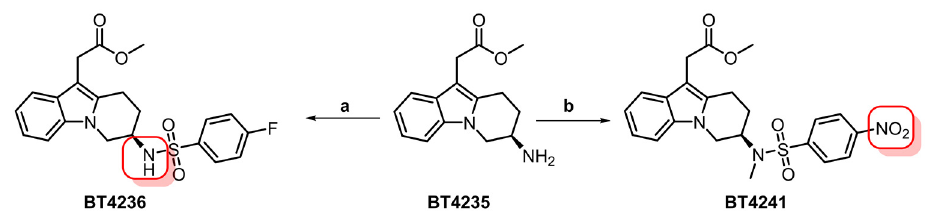
Figure 10. Synthesis of [ 11 C]MK-7246 (BT4236) and [ 18 F]MK-7246 (BT4241) precursors from the common intermediate BT4235. Red squares indicate sites for isotope incorporation. ( a ) 4-fluorobenzenesulfonyl chloride (1.9 equiv.), Et3N (3.1 equiv.), THF, rt, 5 h, 88%. ( b ) (i) 4-nitrobenzenesulfonyl chloride (2.0 equiv.), Et3N (3.1 equiv.), THF, rt, 12 h, 62. (ii) MeI (1.2 equiv.), NaHMDS (1.5 equiv.), DMF/THF, − 40 °C, 3 h, 61%.